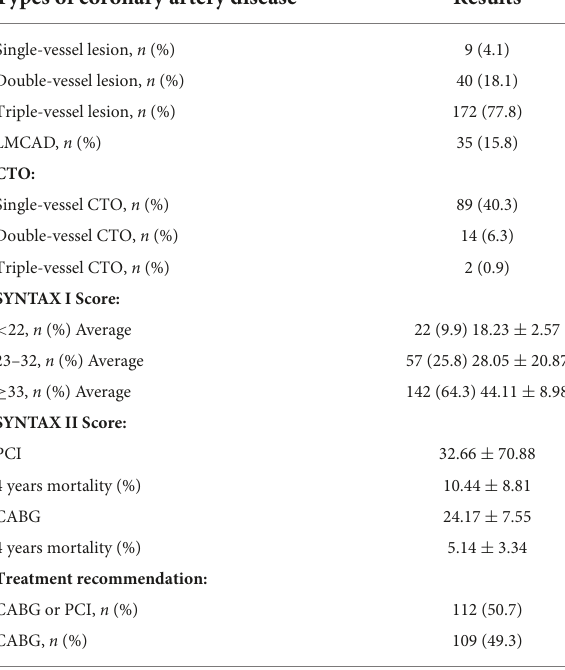
TABLE 2 Characteristics of coronary artery disease and SYNTAX score of patients who underwent TRI using the GGEC I ( n = 221). Types of coronary artery